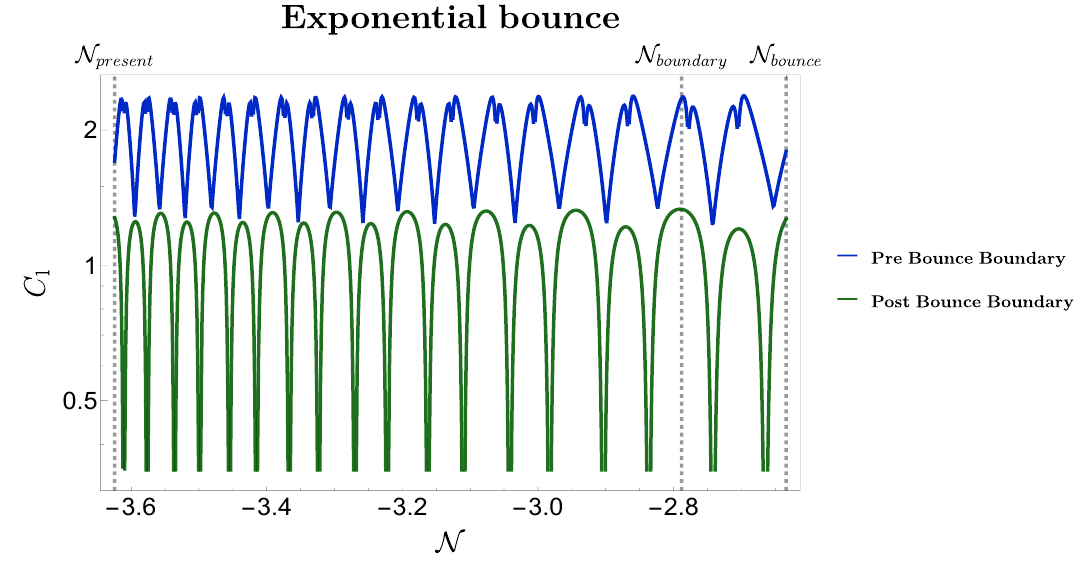
Figure 36: Variation of linearly weighted complexity outside bouncing region with respect to number of